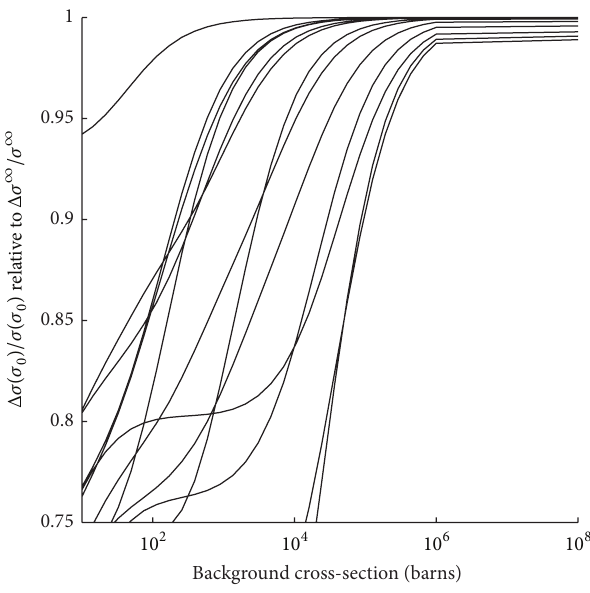
Figure 2: Resonance group Δ𝜎/𝜎 versus dilution relative to infinite dilution of 𝜎 U 238 𝛾 using FCWG.